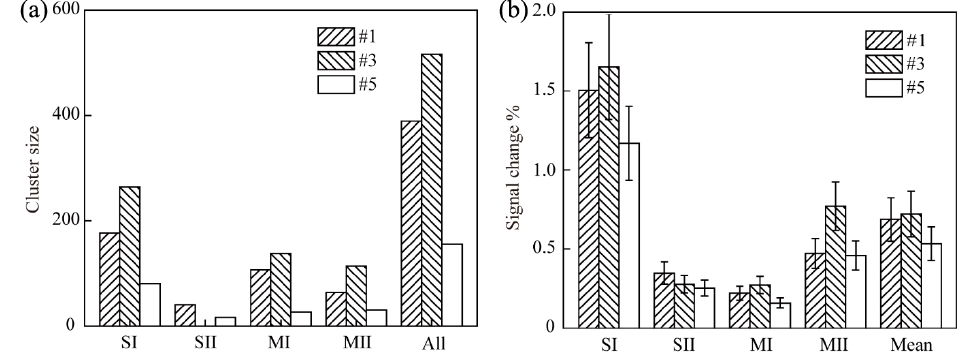
Fig. 10 (a) Activity areas and (b) PSCs of functional regions of the brain during perceiving the